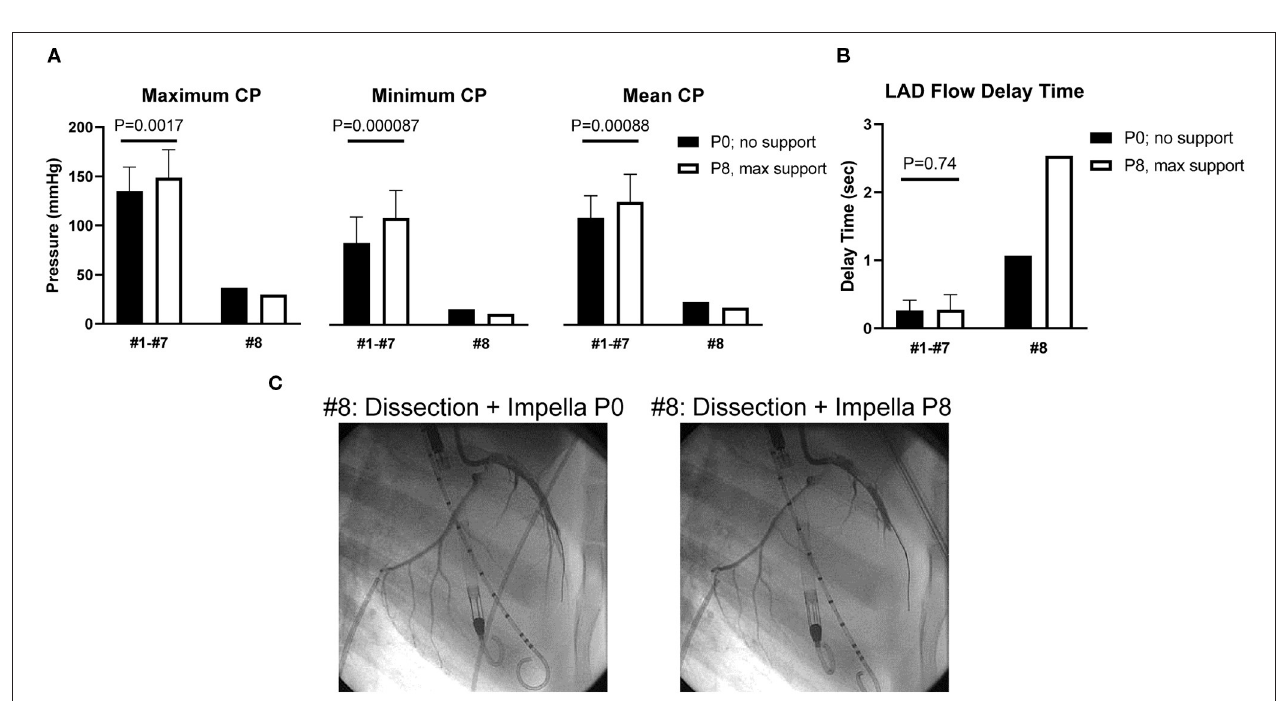
FIGURE 3 | Coronary pressure and flow of the dissected left anterior descending artery. (A) Coronary pressures (CPs) of the true lumen. Minimum and mean coronary pressures increased at Impella max flow (P8) in animals #1–#7, whereas they decreased in animal #8. (B) Left anterior descending artery (LAD) flow delay time (DT) was defined as (LAD filling time) – (LCX filling time). Animal #8 showed increased DT after dissection, and DT prolonged under maximum Impella support, while animals #1–#7 showed unchanged DT. (C) Coronary angiograms of animal #8. Coronary dissection was made in proximal LAD. LAD contrast delay was prominent at maximal Impella support (P8, right side). Movies of the angiograms are provided in Supplementary Movies .